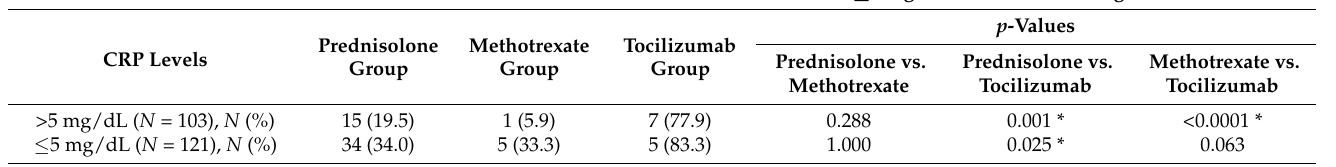
Table 5. Prednisolone discontinuation rates at the last visit when patients were divided ( A ) by the CRP levels at diagnosis and ( B ) by initial prednisolone